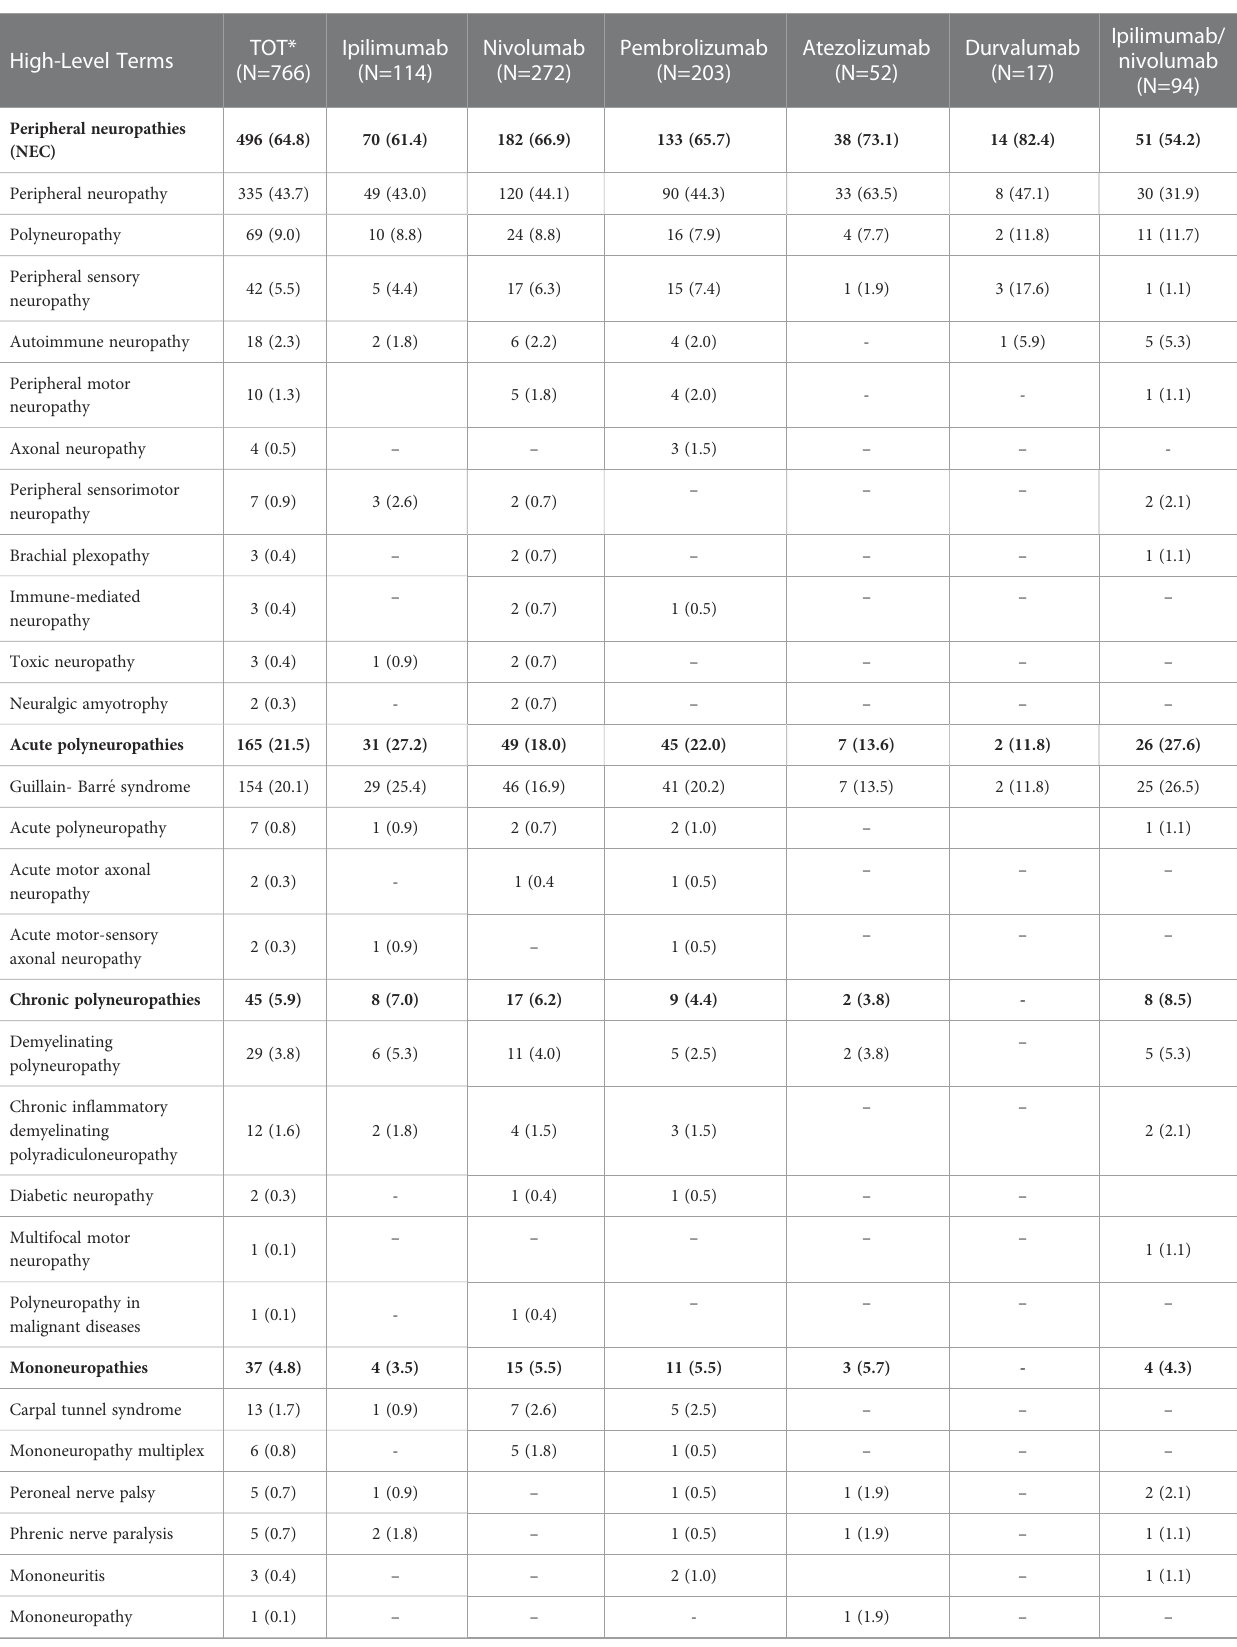
TABLE 2 Distribution of neurological complications included in the “ Peripheral neuropathies ” HGLT that occurred in European patients treated with at least one